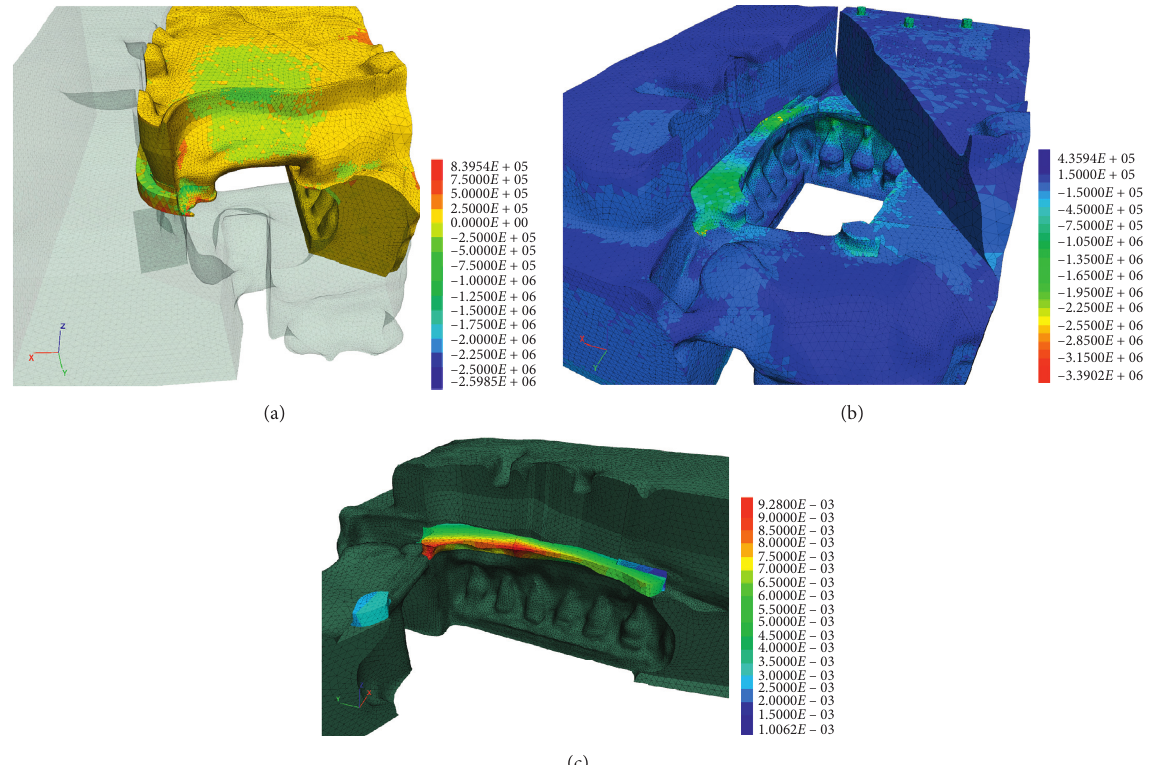
Figure 13: Stress nephogram of local model of Yuanjue Cave. (a) Horizontal stress field of roof, (b) maximum principal stress field of the supporting block, and (c) deformation characteristics of supporting